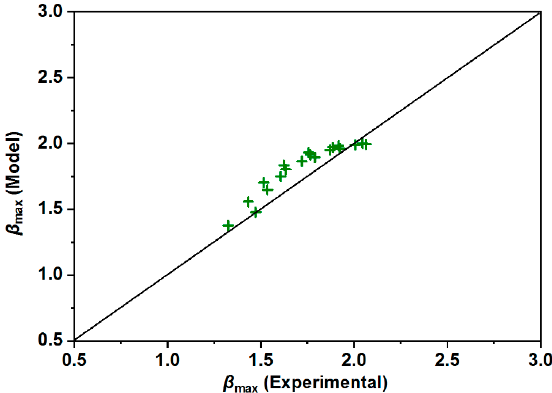
Figure 11. Comparison of additional experimental data against the present model.